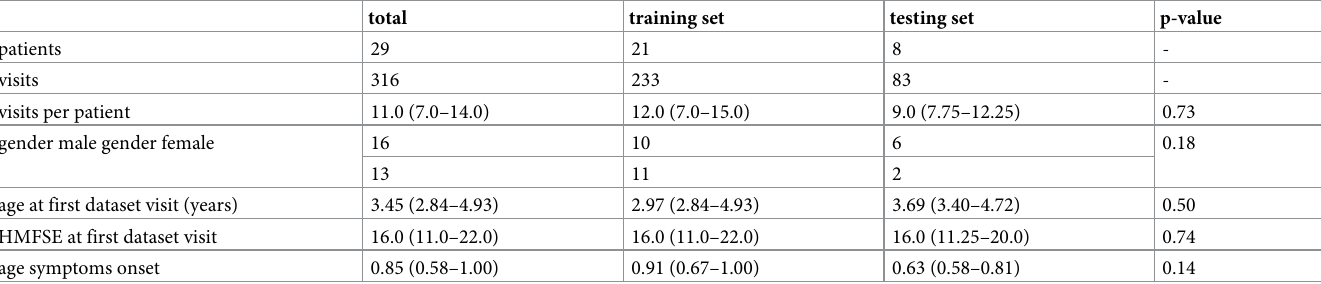
Table 2. 12-months HMFSE dataset summary. Numerical values are reported as median and interquartile range.